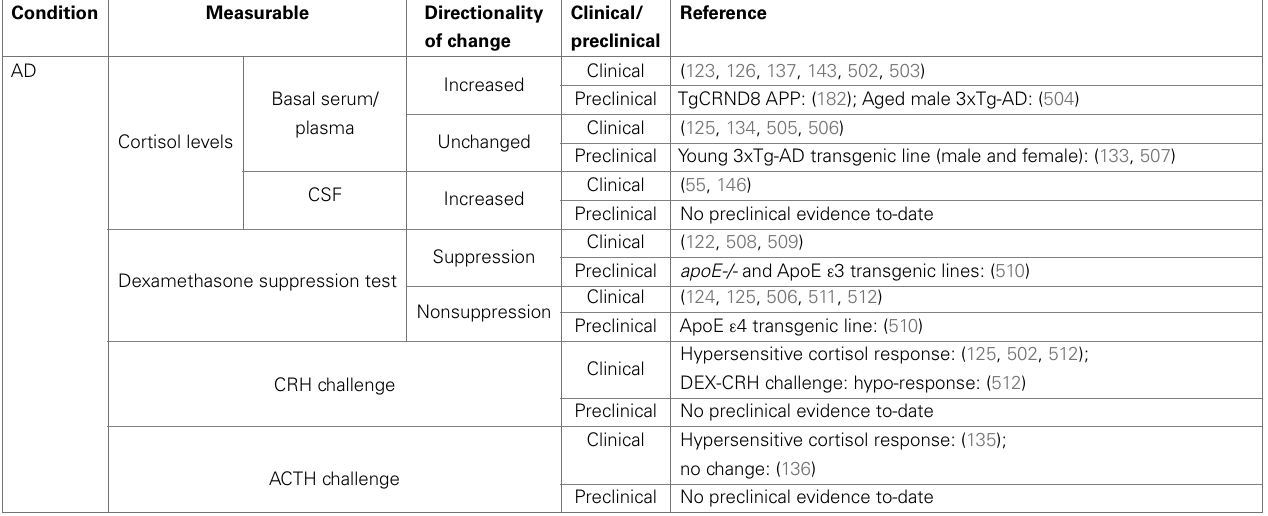
Table 1 | Summary of clinical and preclinical evidence for HPA-axis pathology inAlzheimer’s disease .